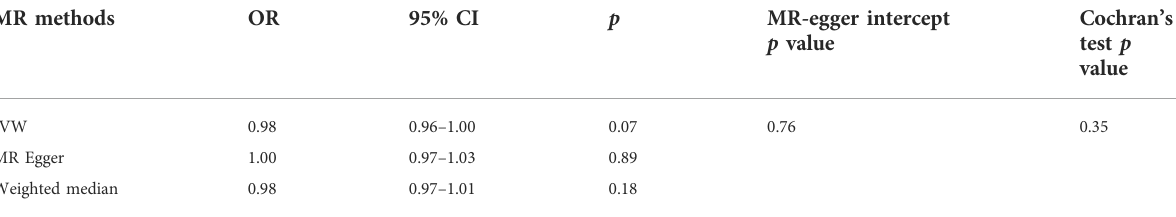
TABLE 2 Mendelian randomization from circulating 25(OH)D concentration on low back pain experienced last month.